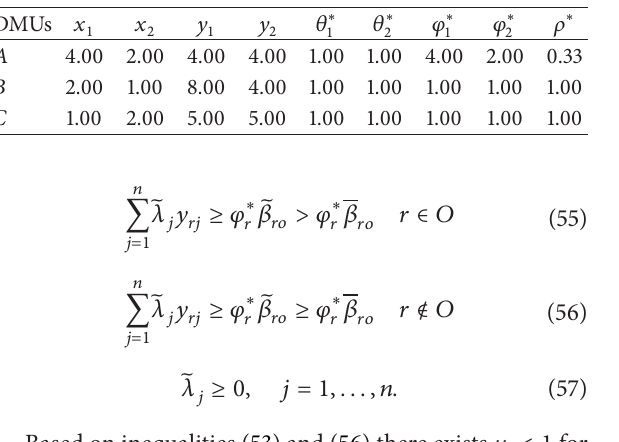
Table 1: The data and ERM efficiency in Example